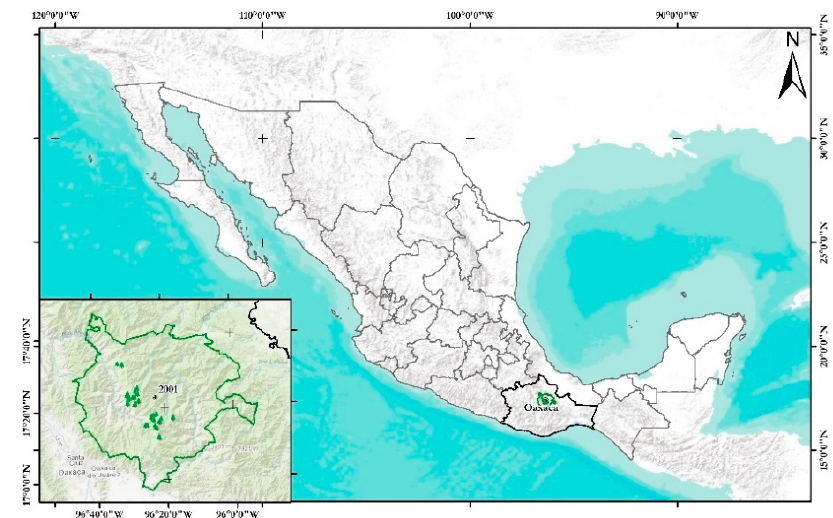
Figure 1. Location of the study area in Oaxaca, Mexico.